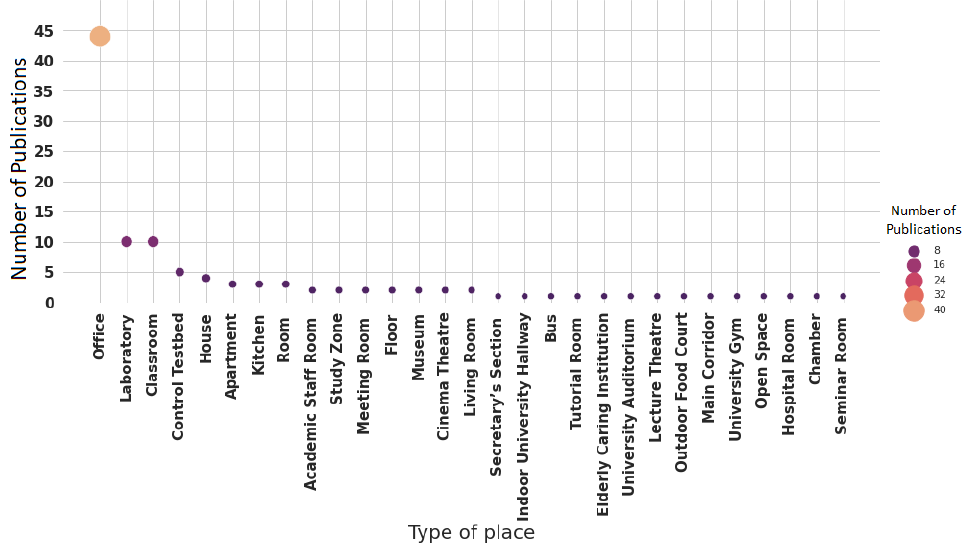
Figure 11. Test-bed scenarios reported in the